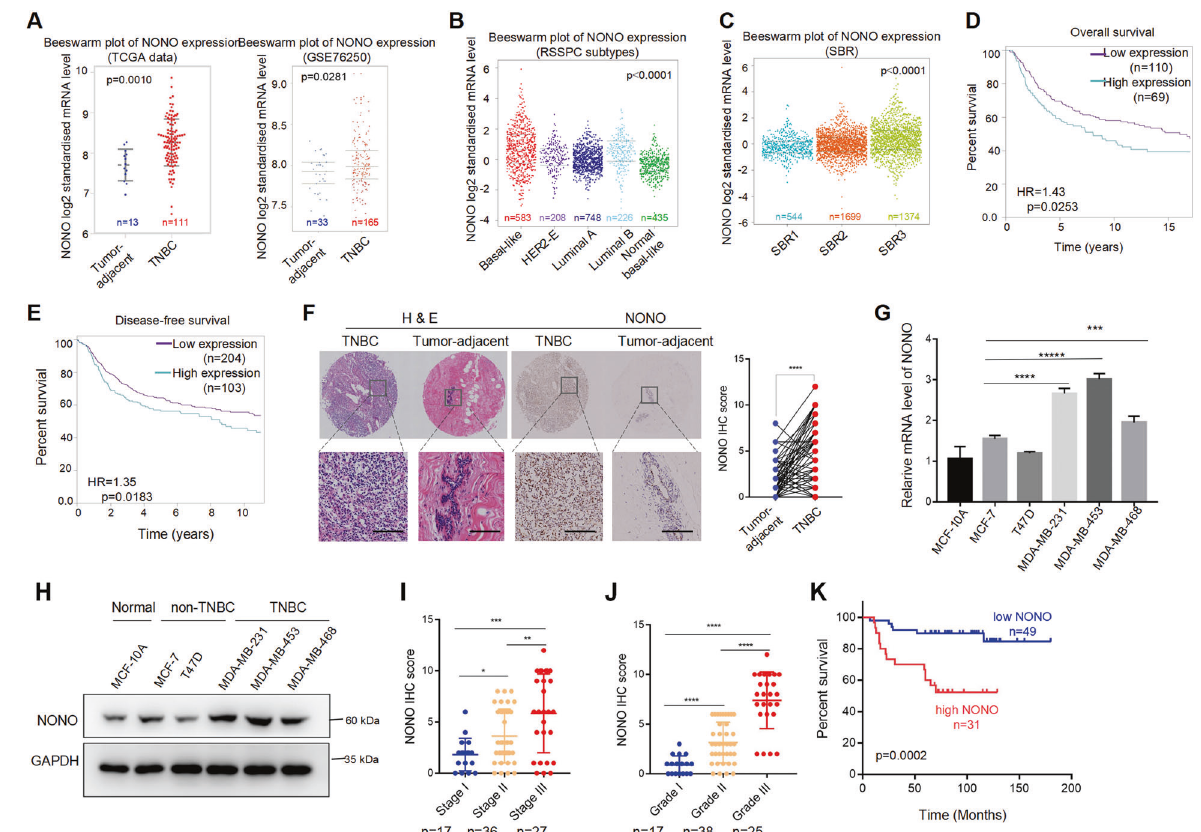
Fig. 3 NONO is upregulated in TNBC and associates with breast cancer malignancy. A Beeswarm plots showed the NONO mRNA expression (Log 2 ) levels in TNBC and tumor-adjacent tissues from TCGA-TNBC cohort (left) and GSE76250 (right). (TCGA: Tumor adjacent ( n = 13) < TNBC ( n = 111), p = 0.0010; GSE76250: Tumor adjacent ( n = 33) < TNBC ( n = 165), p = 0.0281). B Beeswarm plots showed the NONO mRNA expression (Log 2 ) levels in different subtypes of breast cancer. (Basal-like, n = 583; HER2-E, n = 208; Luminal A, n = 748; Luminal B, n = 226; Normal breast-like, n = 435; Basal-like > Normal breast-like, p < 0.0001; Basal-like > luminal A, p < 0.0001; Basal-like > luminal B, p < 0.05; Basal-like > HER2-E, p < 0.001). C Beeswarm plots showed the NONO mRNA expression (Log2) levels in different tumor grade status. (SBR1, n = 544; SBR2, n = 1699; SBR3, n = 1374; SBR2 > SBR1, p < 0.0001; SBR3 > SBR1, p < 0.0001; SBR3 > SBR2, p < 0.0001). D Kaplan – Meier analysis of overall survival (OS) (log-rank, two sides) of TNBC patients with low ( n = 110) or high ( n = 69) mRNA level of NONO from bc-GenExMiner v4.5 (http://bcgenex.centregauducheau.fr/bc-gem/gem-accueil.php?js = 1) based on DNA microarray data. E Kaplan – Meier analysis of disease-free survival (DFS) of TNBC patients with low ( n = 204) or high ( n = 103) mRNA level of NONO from bc-GenExMiner v4.5 based on DNA microarray data. F The quantitative expression of NONO protein in 80 paired TNBC tissues was analyzed by IHC. Representative H&E (left) and IHC staining (right) images showed the protein level of NONO in TNBC and paired adjacent normal breast tissue. Scale bar = 100 μ m (×200). G , H The mRNA ( G ) and protein ( H ) level of NONO in different breast cancer cell lines. I , J The protein level of NONO in different tumor stages ( I ) and grades ( J ) of TNBC. K Kaplan – Meier analysis of overall survival of TNBC patients with low ( n = 49) or high ( n = 31) expression of NONO protein. The displayed values are the mean ± SD. The triplicate measurement results were repeated 3 times and the results were similar ( G , H ). * P < 0.05; ** P < 0.01; *** P < 0.01 versus the corresponding